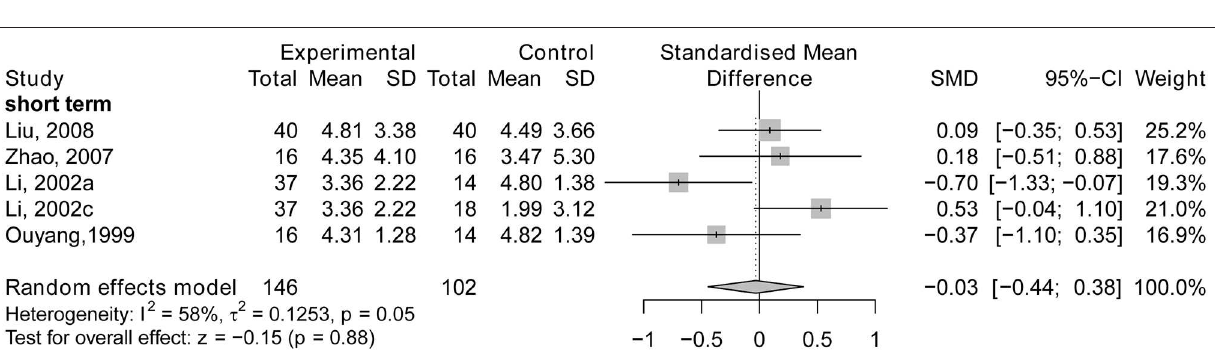
see Figure 12 ). One study (Lou et al., 2017) demonstrated that acupuncture combined with drug therapy had a more beneficial effect on ADLs in AD patients than drug therapy alone